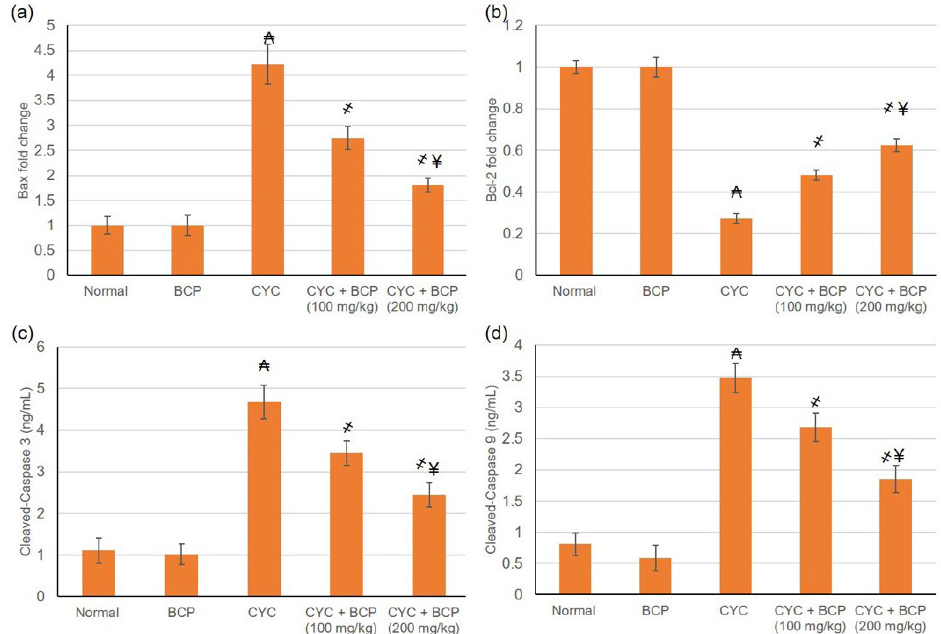
Figure 6. Effects of treatment with β -caryophyllene (BCP) for 14 days on cyclophosphamide (CYC) induced variations on the apoptotic markers including ( a ) Bax, ( b ) Bcl2, ( c ) caspase-3 and ( d ) caspase-9 in rats. All values are expressed as mean ± SD. ₳ indicates a statistically significant differ- ence from normal group;